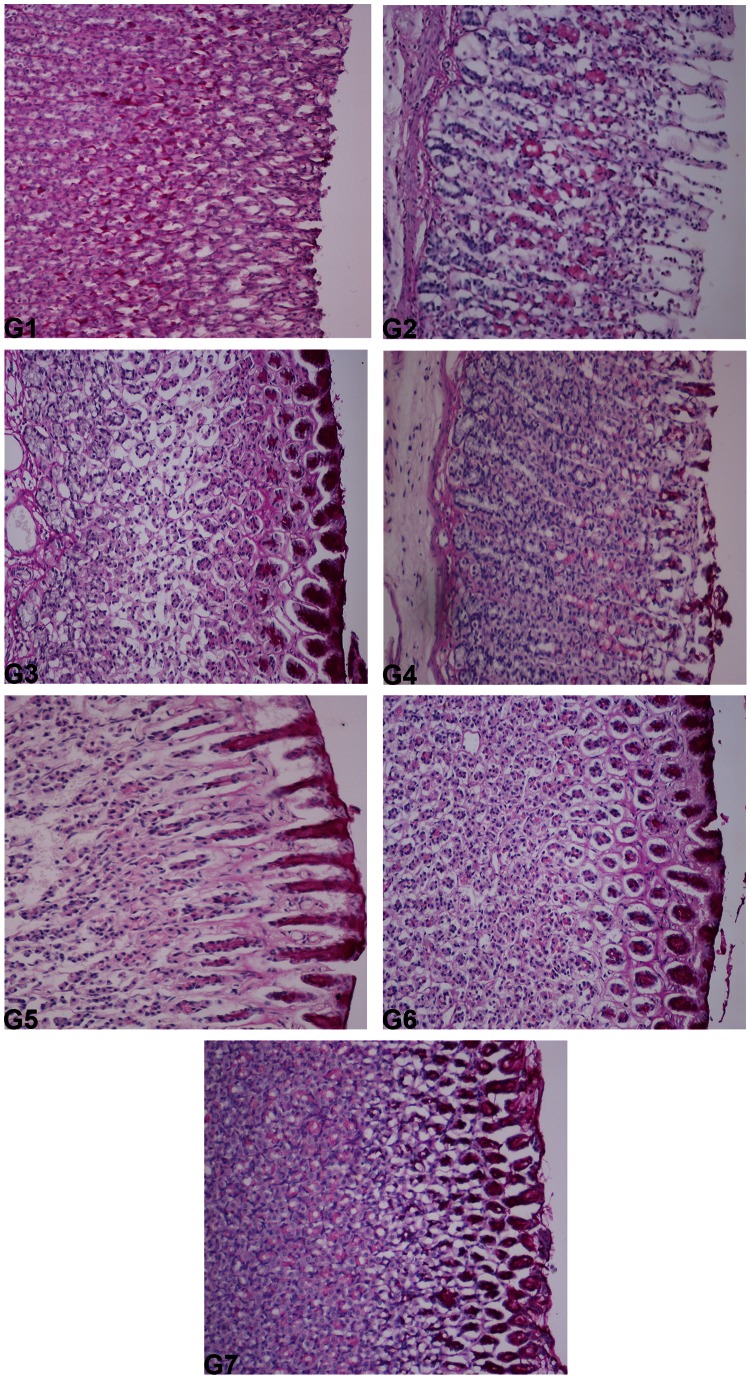
The effect of Parkia speciosa on gastric tissue glycoprotein-PAS staining in ethanol-induced gastric ulcers in rats.(G1) (Normal control group); (G2) (Ulcer control group); (G3) (Omeprazole); (G4) (50 mg/kg), (G5) (100 mg/kg), (G6) (200 mg/kg), (G7) (400 mg/kg) Parkia speciosa extract (PAS stain 20×).